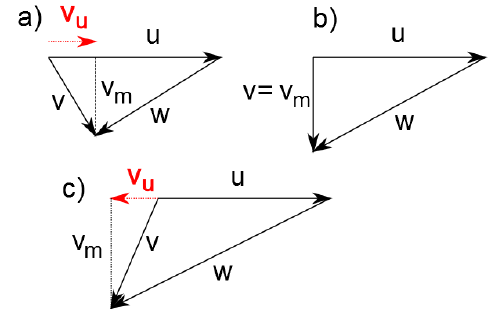
Fig. 1. Connection between the velocity triangle on runner exit and the residual swirl for a) partload, b) best efficiency point, c)